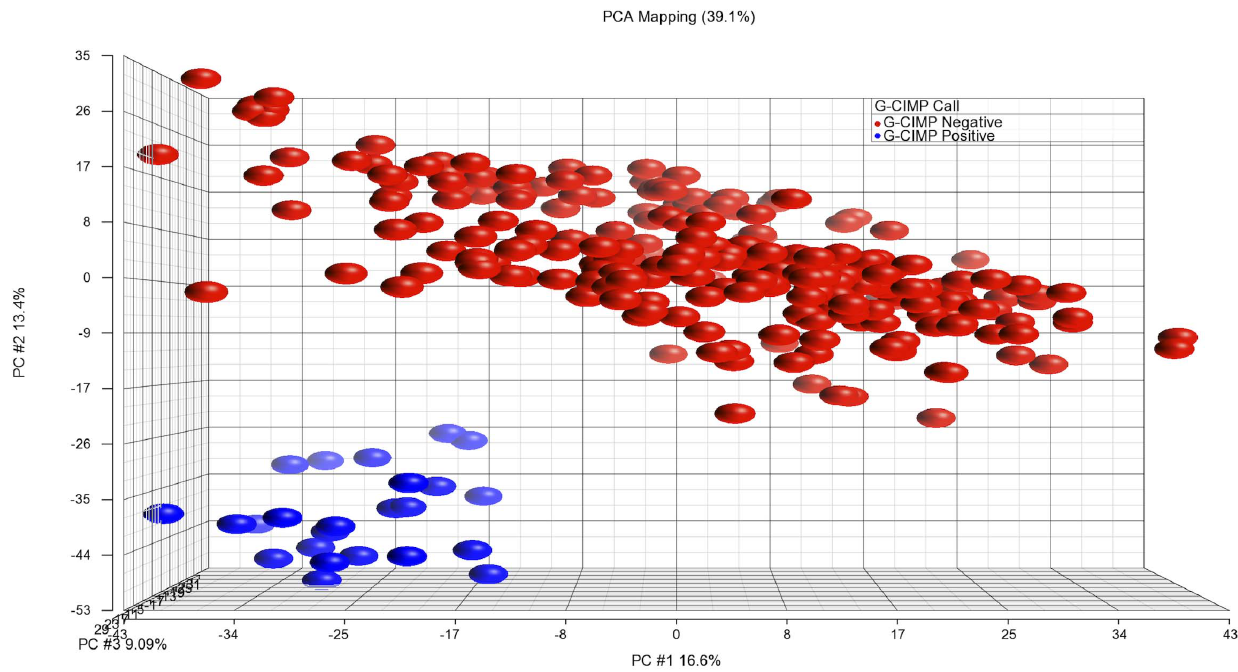
Figure 1. PCA plot of GBM samples with methylation data. Red: G-CIMP negative, Blue: G-CIMP positive. Methylation sites with std. deviation . 0.2 are selected to generate this graph.